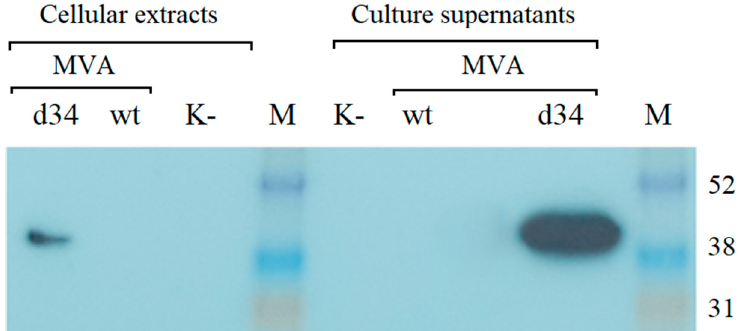
Figure 3. Western blot analysis of d34 antigen expression in BHK-21 cells after infection with the MVA-wt virus or recombinant rMVA-d34 virus (MOI = 2) using anti-6x-His Tag antibodies for detection. M is a marker of the molecular weight of proteins. K- indicates uninfected BHK-21 cells. The molecular weight of the d34 protein is 48.3 kDa. M-ECL™ Rainbow™ marker.